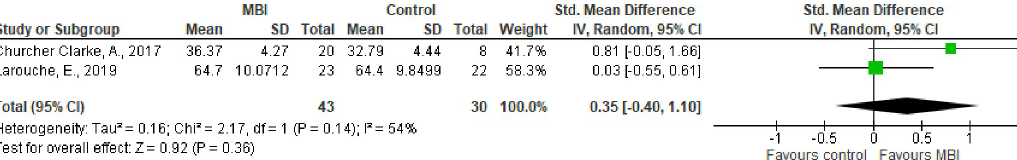
Fig 9. Forest plot of comparison: Quality of life, MBI versus control after 6 to 10 weeks from the beginning of the intervention.